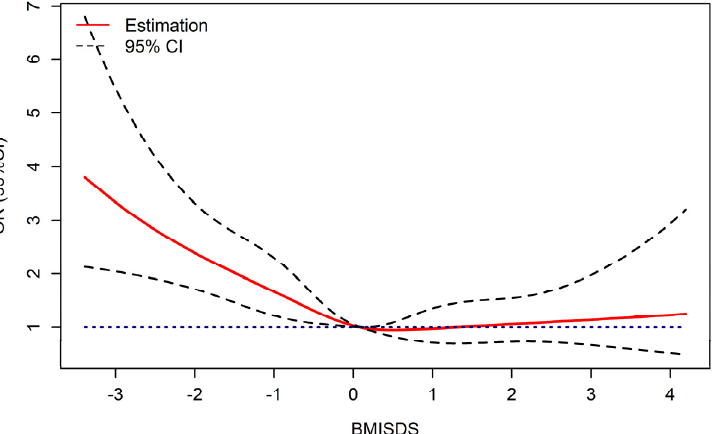
Figure 1. Dose-response relationship of BMISDS with low IGF-1 levels (adjusted for pubertal devel- opment and height standard deviation scores). OR: odds ratios, CI: confidence intervals, BMISDS: body mass index standard deviation scores, IGF-1: insulin-like growth factor-1. Blue dashed line represents OR = 1.